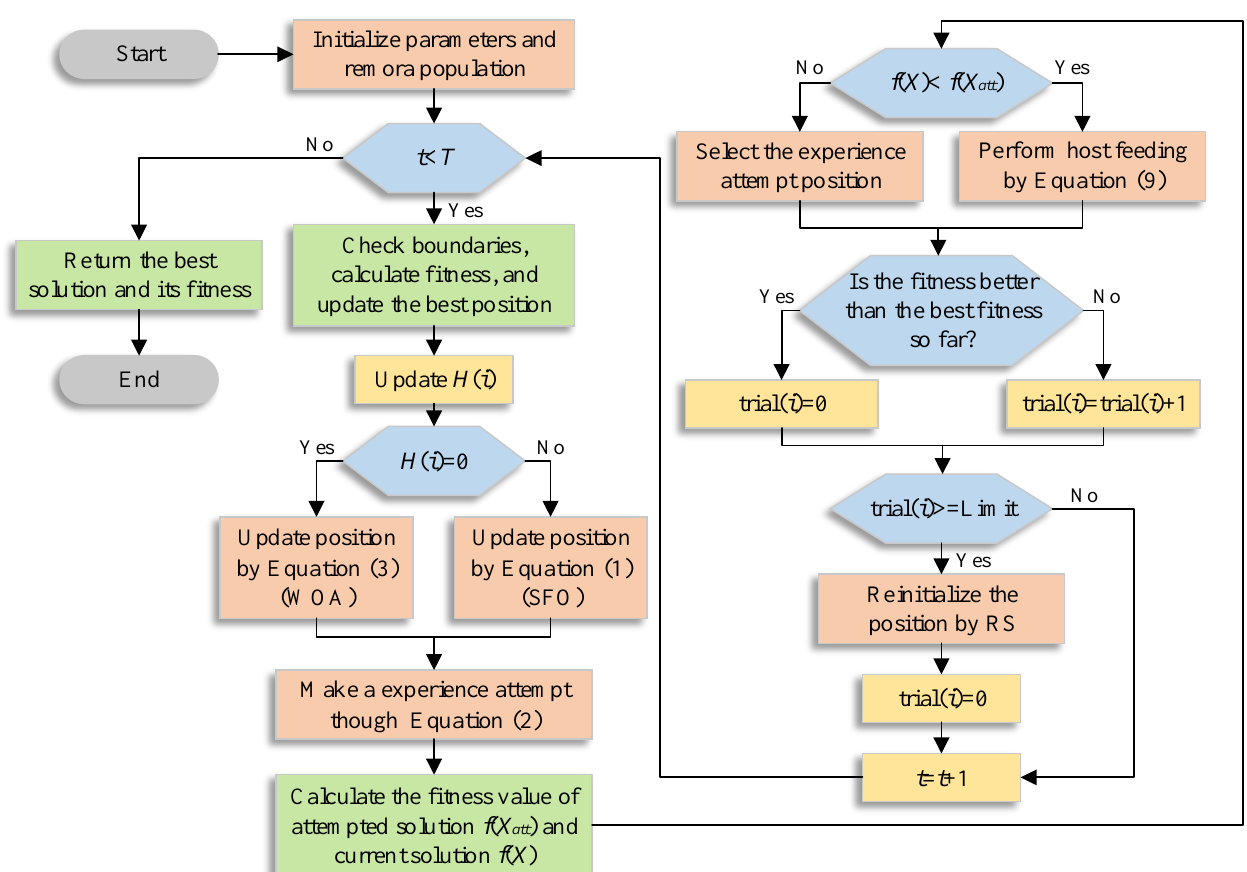
Figure 2. The flowchart of the EROA.